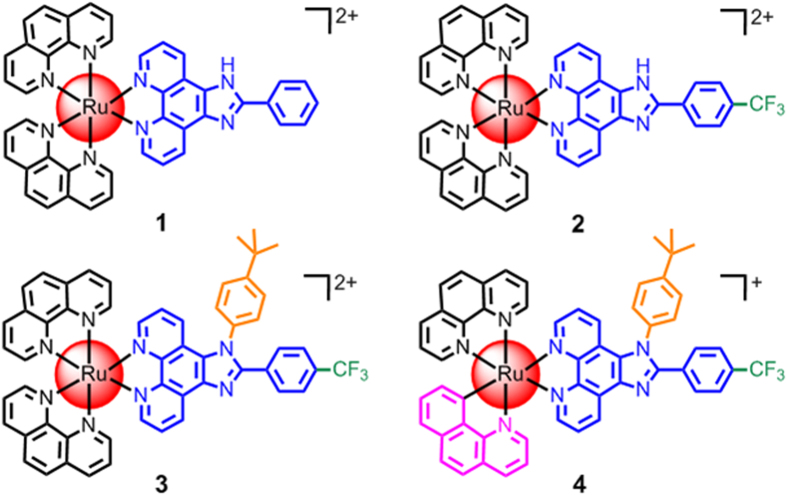
The chemical structures of Ru(II) complexes 1–4.